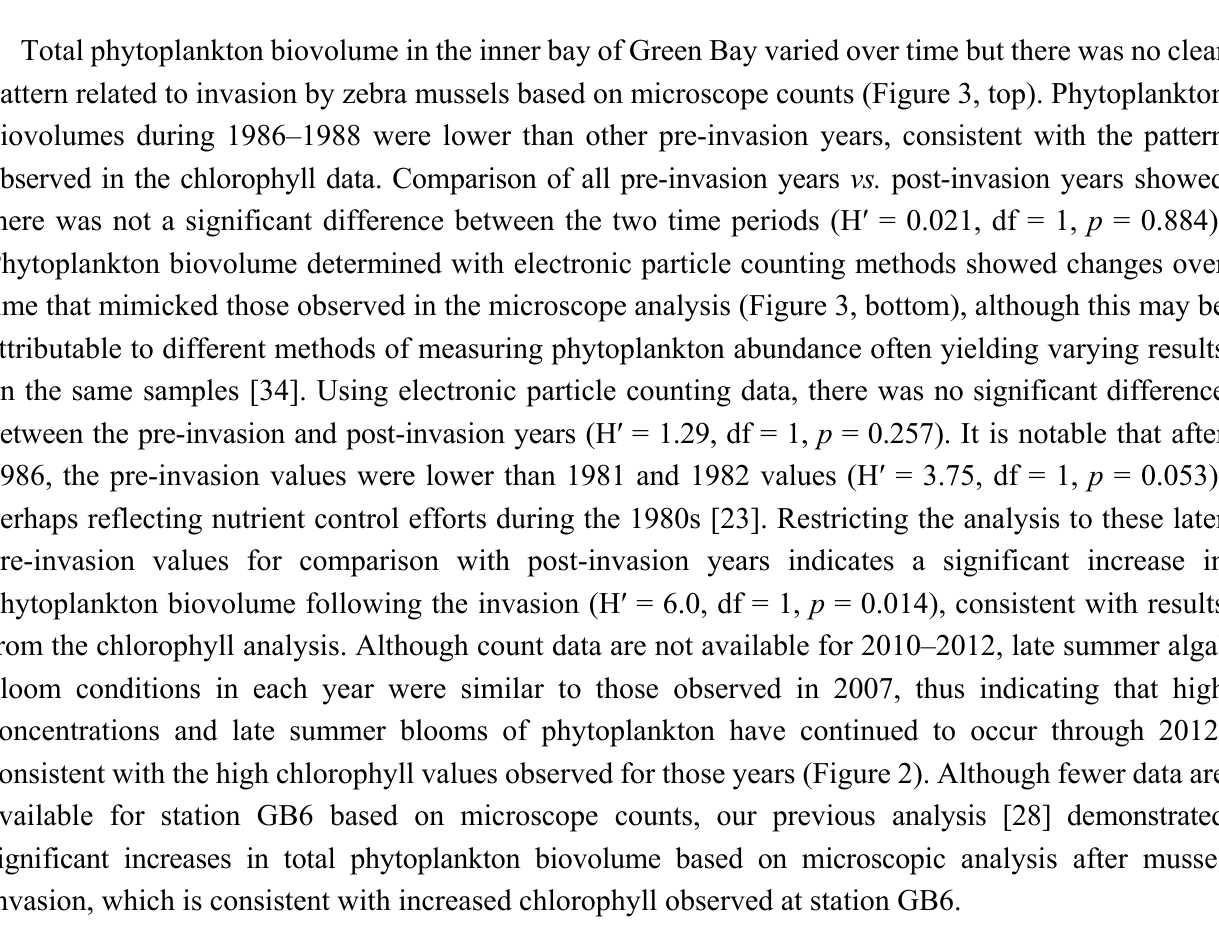
Figure 3. Total phytoplankton biovolume (summer mean ±1 SEM) based on microscope counts (top panel) and from electronic particle counts (bottom panel) from all inner bay sites of Green Bay. Open bars are pre-invasion years, black bars are post-invasion